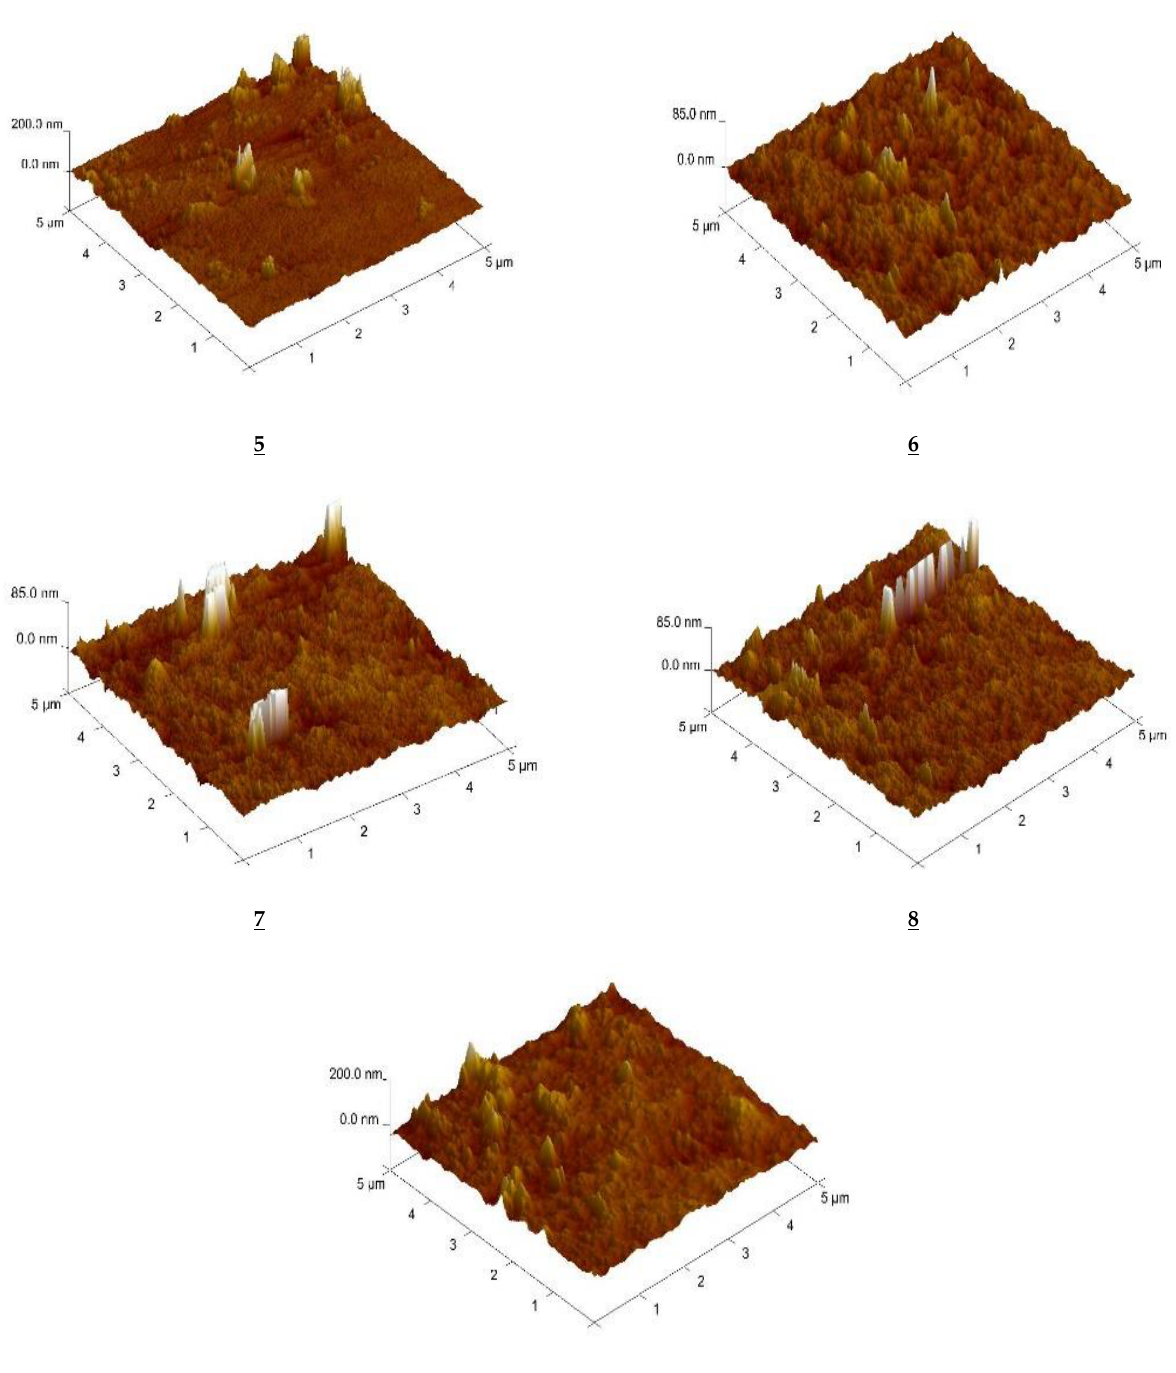
Figure 2. AFM pictures of the PIMs with 1-alkyl-triazole 1 – 9 .